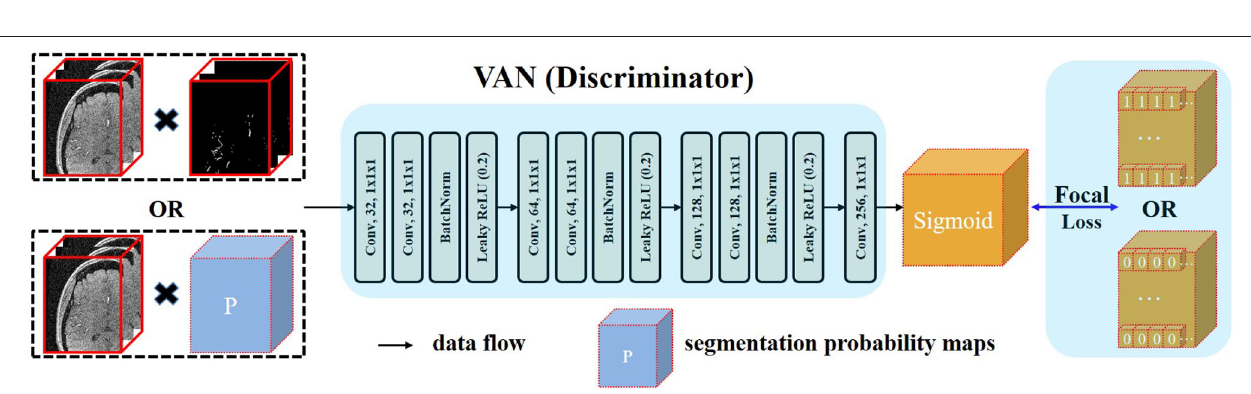
FIGURE 1 | Architecture of our proposed FiboNet as the generator. Fibonacci connection of feature maps are utilized to build the Fibonacci block. In Fibonacci block, feature maps from previous two layers are concatenated as the input of the current layer. The technique called deep supervision, which is commonly used in convolutional neural network (CNN)-based medical image segmentation, is also incorporated.